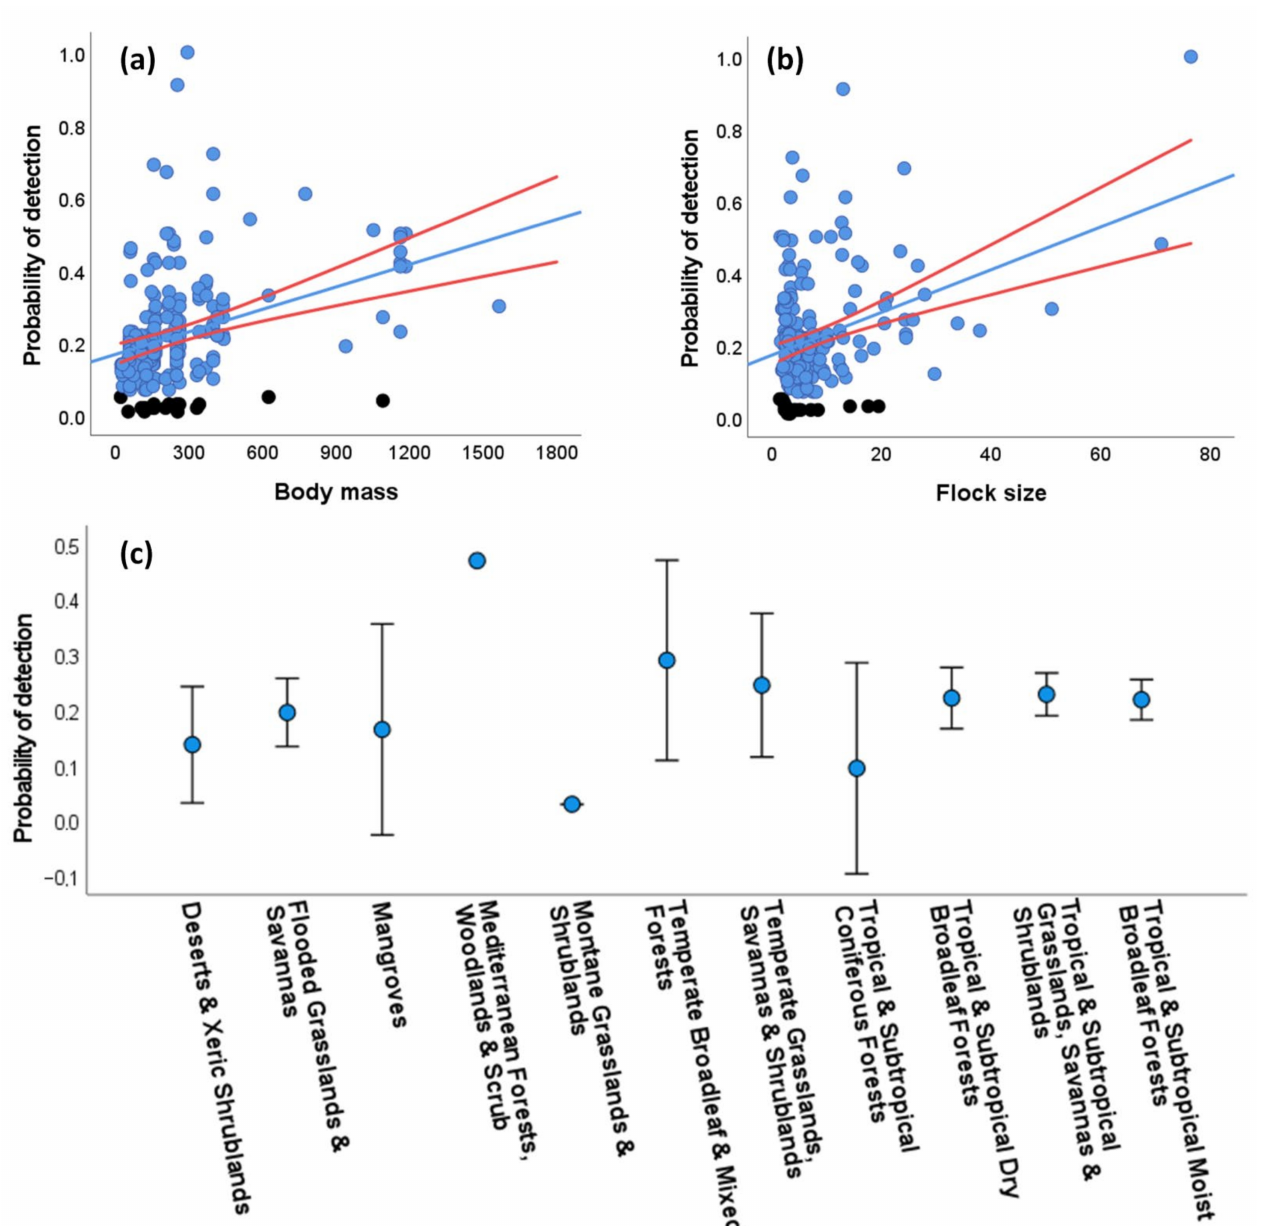
Figure 3. Univariate relationships between the probability of detection (P) of parrots obtained through distance sampling (DS) modeling and ( a ) parrot body mass (in g), ( b ) average flock size (number of individuals/number of visual encounters), and ( c ) the biomes surveyed for 208 study cases with at least 10 visual encounters at distances ≤ 500 m per parrot species. Black dots (in a , b ) correspond to extremely low, questionable P values (see text for more details). Red lines (in a , b ) and bars (in c ) show 95% confidence intervals. See Results (Section 3.3.2) for multivariate